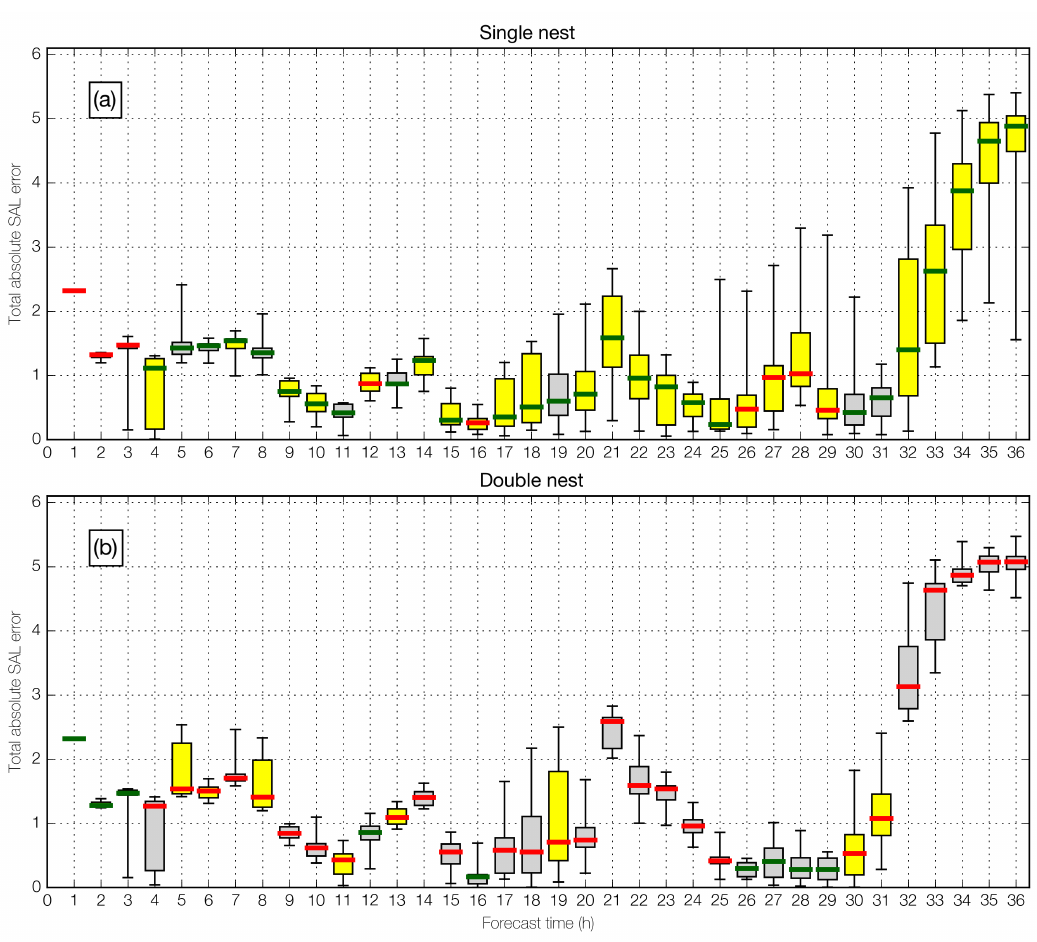
Figure 6. Box plot of total absolute SAL (taSAL) for the ( a ) single- and ( b ) double-nested EPSs. Features shown include median (linearly interpolated; horizontal line), interquartile range (box), and spread of the whole ensemble (whiskers). The lower median (better forecast) at each time is colored green, while the higher median is red. The larger interquartile range at each time is colored yellow; the smaller is colored